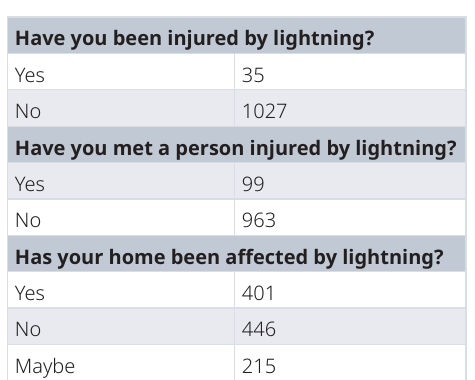
Table 1. Respondents’ exposure to lightning